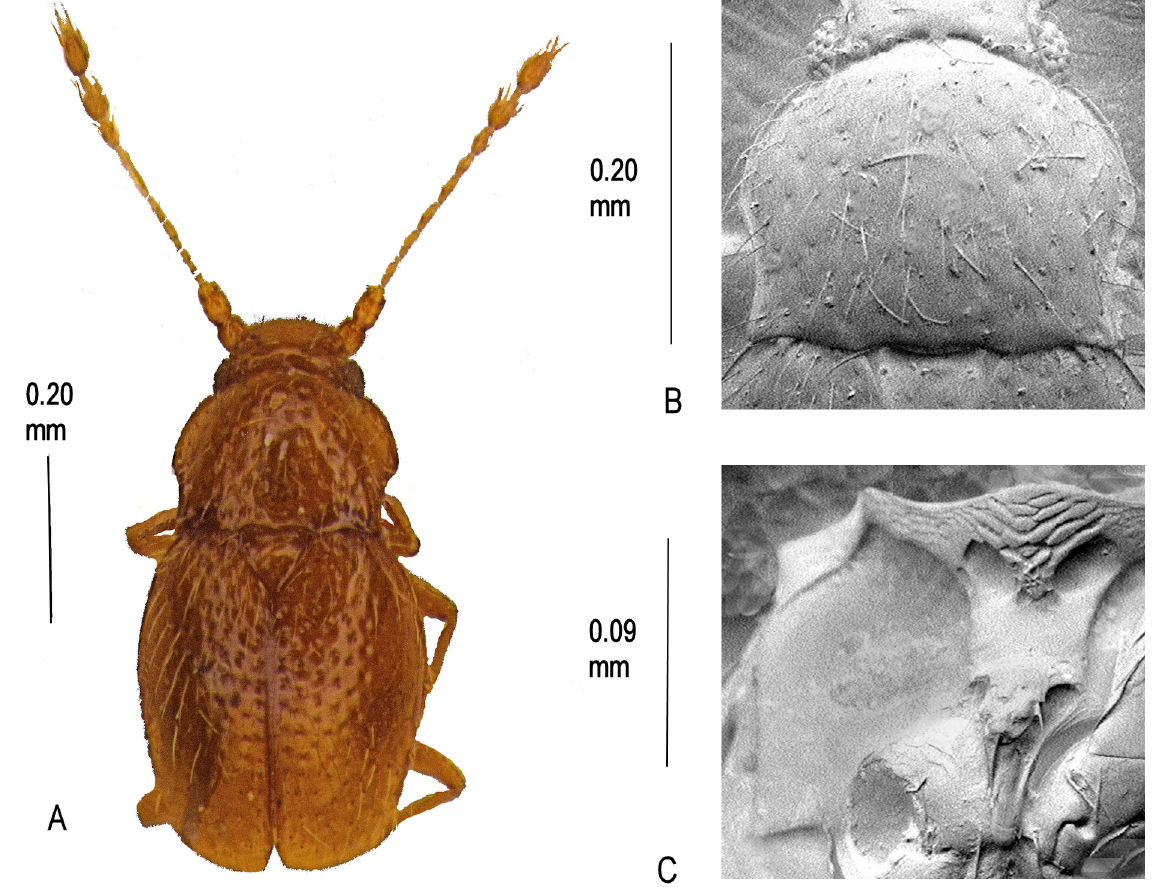
Fig. 92. Cissidium dybasi sp. nov. A . Habitus. B . Pronotum, × 370. C . Mesoventrite showing median process of collar, lateral margin, mid-keel and keel, ×